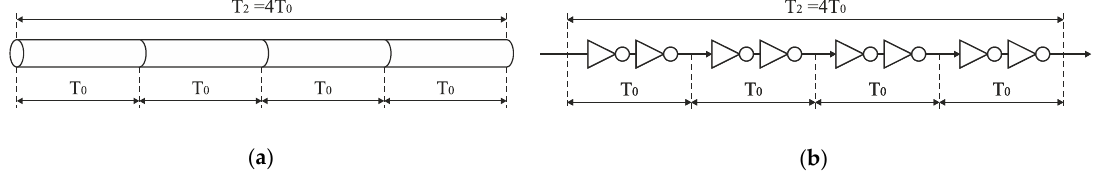
Figure 23. ( a ) Concept of delay lines design; ( b ) delay line T 2 as a cascade of 4 inverters pairs.